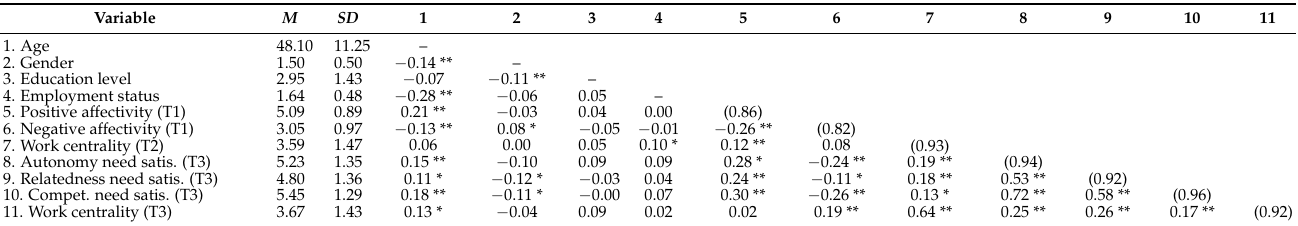
Table 3. Descriptive Statistics and Correlations among Variables.